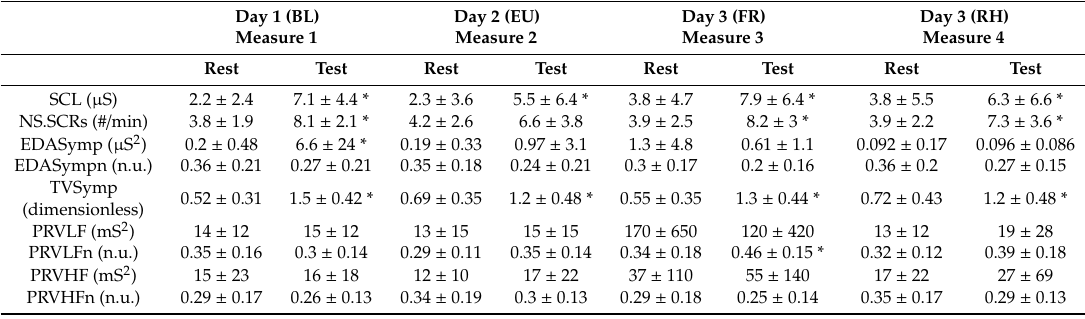
Figure 1. EDA and heart rate (HR) during rest and test stages of the Stroop task, for a given subject. Table 5. Measurements of autonomic response based on EDA and PRV during the rest and test stages of the Stroop task throughout the study.